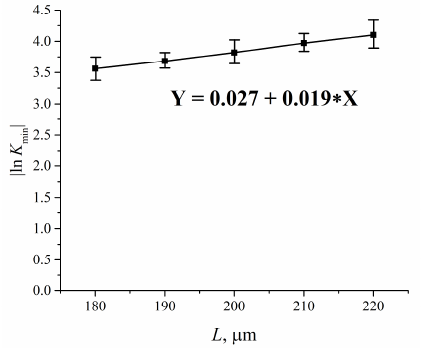
Figure 5. Dependence |ln K min | vs. the distance, L , between the cell windows for water. K min is related to the spectral minimum of the graph in Figure 4. The dependence |ln K min | ( L ) is well approximated by function Y = 0.027 + 0.019 X.